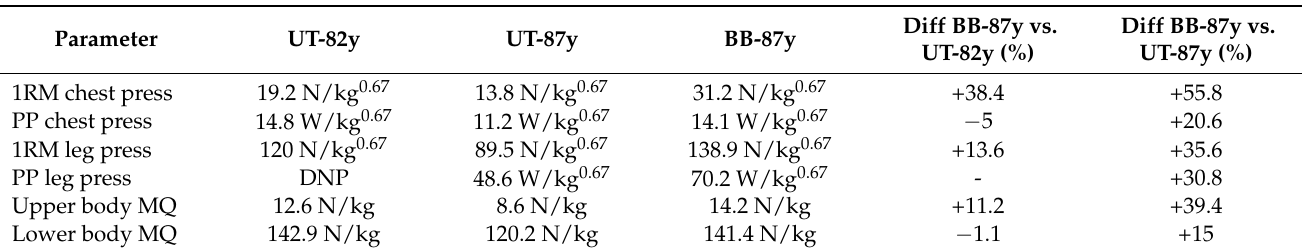
Table 2. Comparisons between the 87-year-old bodybuilder and untrained older males of a similar age for strength, power, and muscle